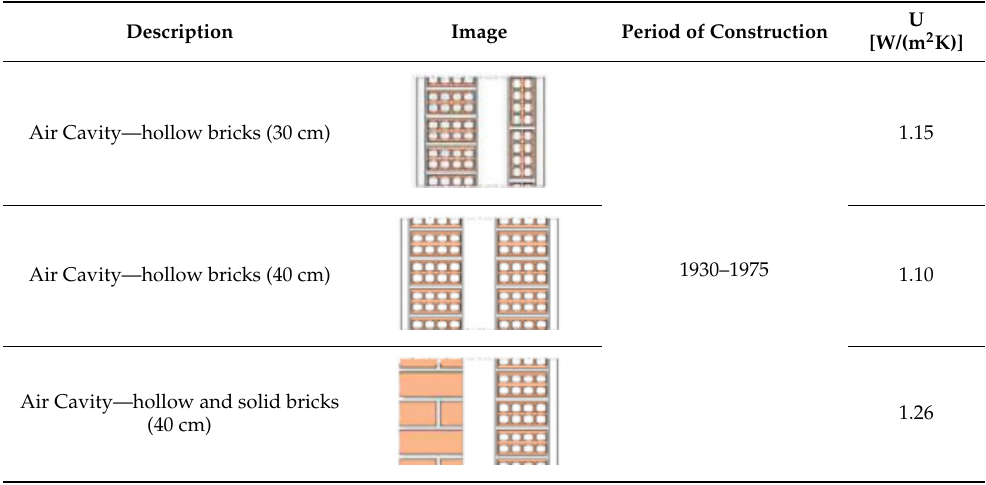
Table 1. Building Typology Brochure — Italy (https://episcope.eu/communication/download/ (accessed on 15 September 2022)).